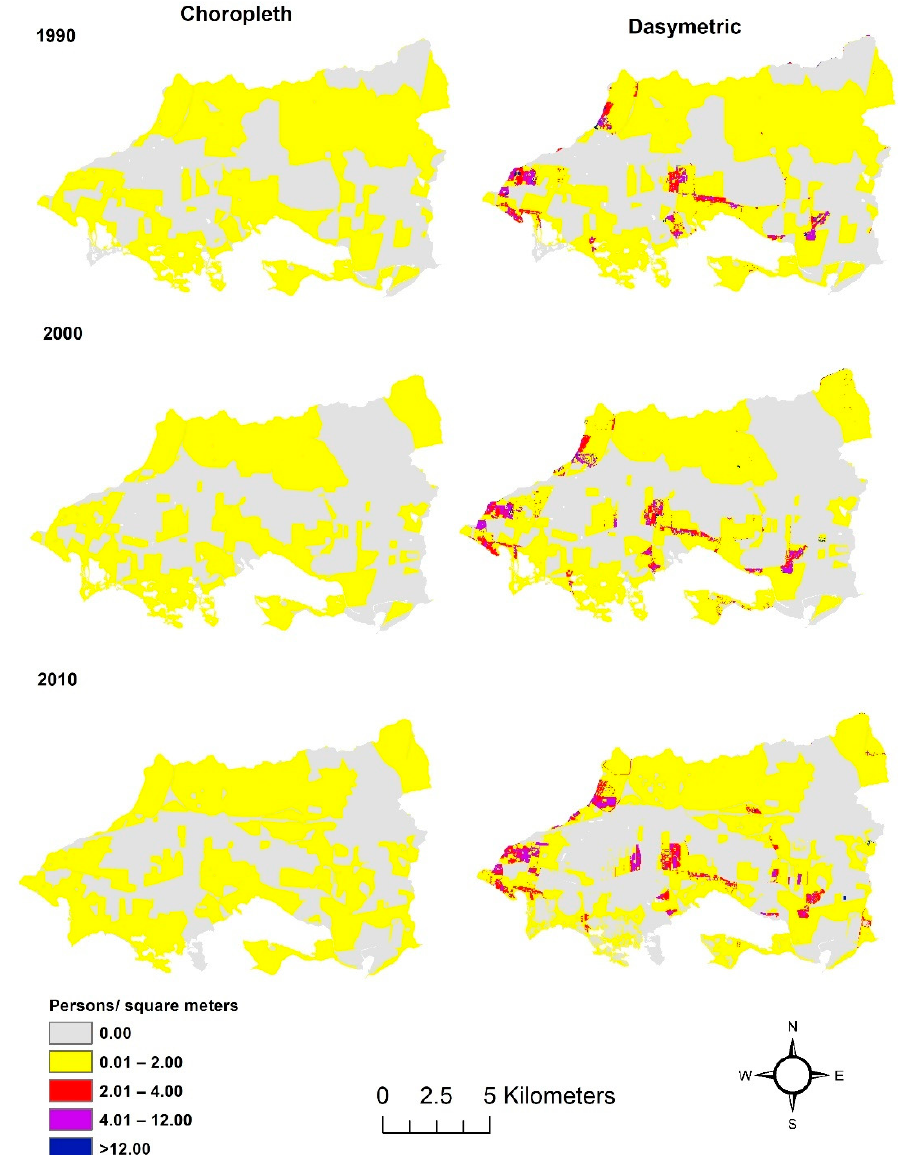
Figure 5. Visual comparison of the choropleth and the dasymetric population density map for JBNERR census blocks.